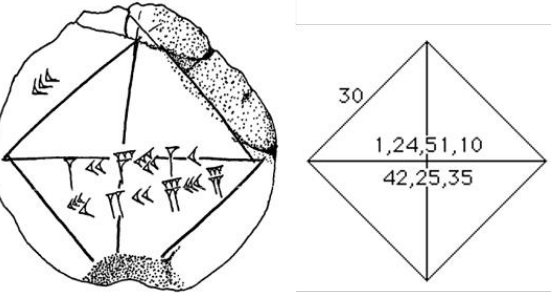
Figure 3. Tablet YBC-7289 ( left ) and a transcription of the mathematical cuneiform text ( right ) [15]. In addition, tablet YBC 7290 demonstrates how to find the area of a trapezium by multiplying the averages of the bases and sides [16]. Furthermore, tablet YBC 7290 shows how to multiply the averages of the bases and sides to obtain the area of a trapezium [15]. The date of all of these tablets is unknown, but it is generally agreed that they came back between 1800 and 1600